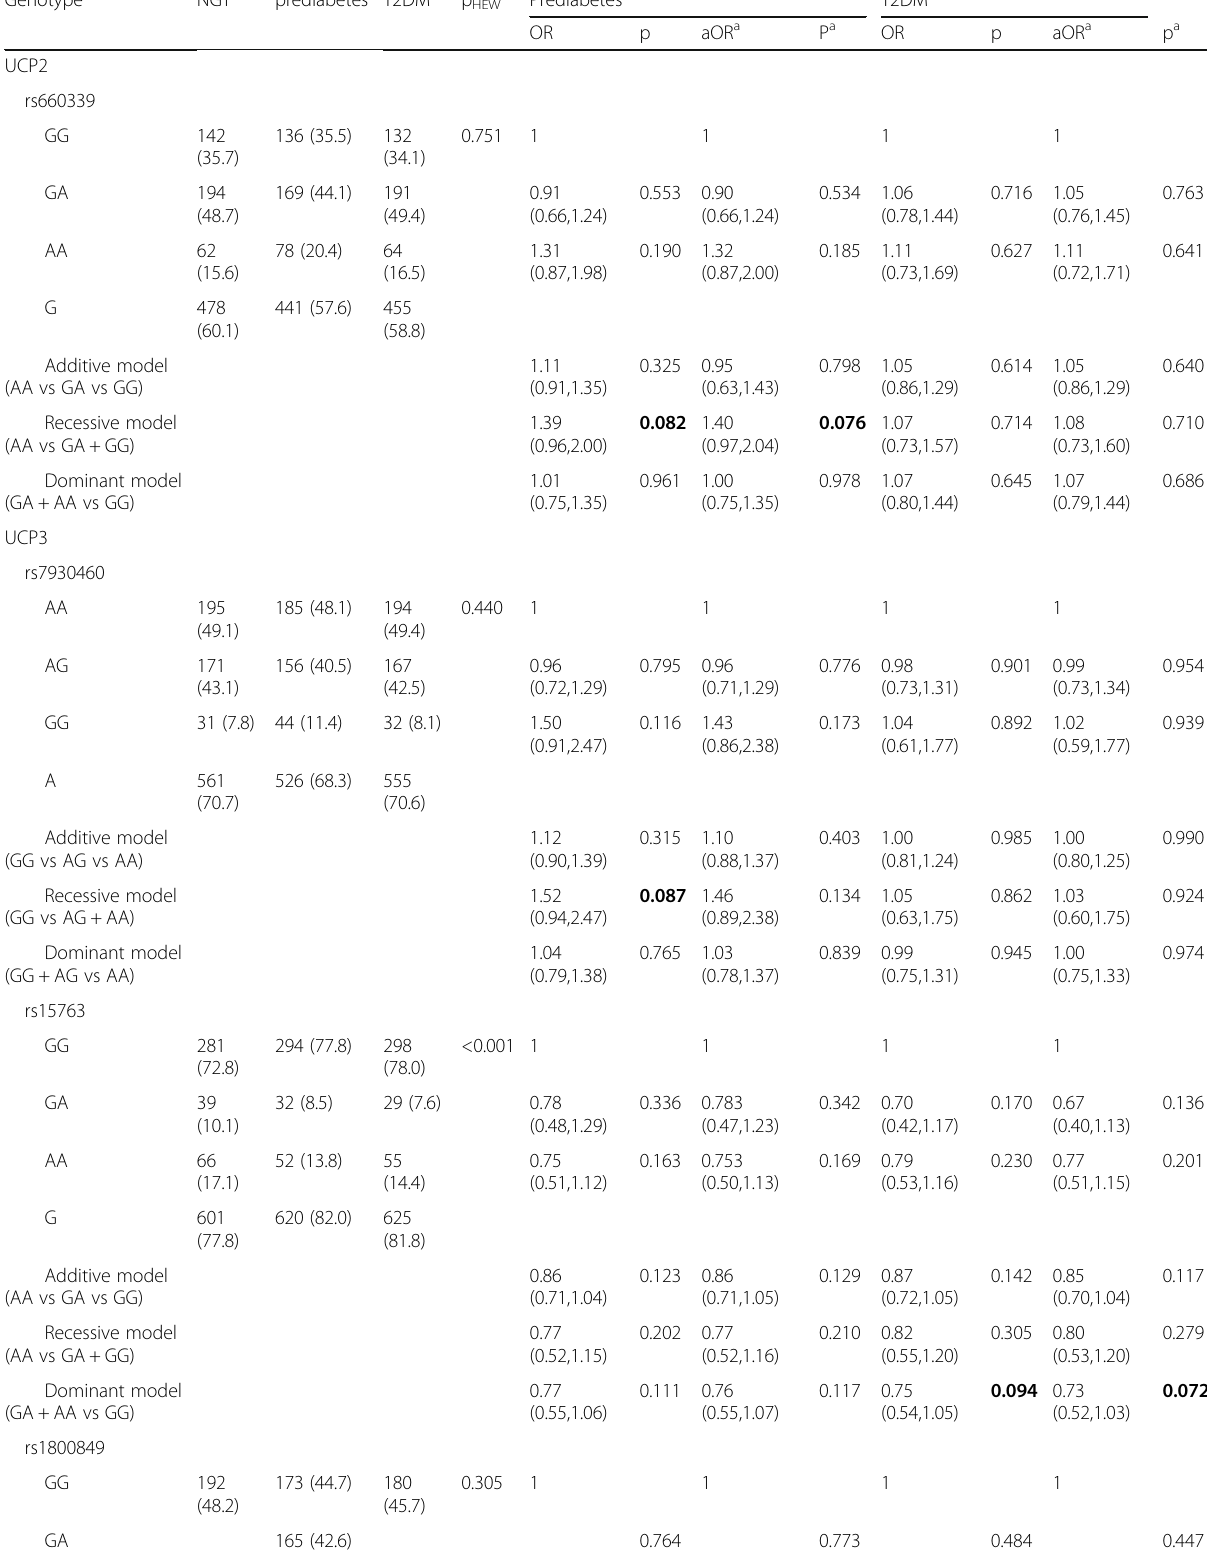
Table 2 Potential prediabetes or T2DM-associated UCP2 and UCP3 polymorphisms